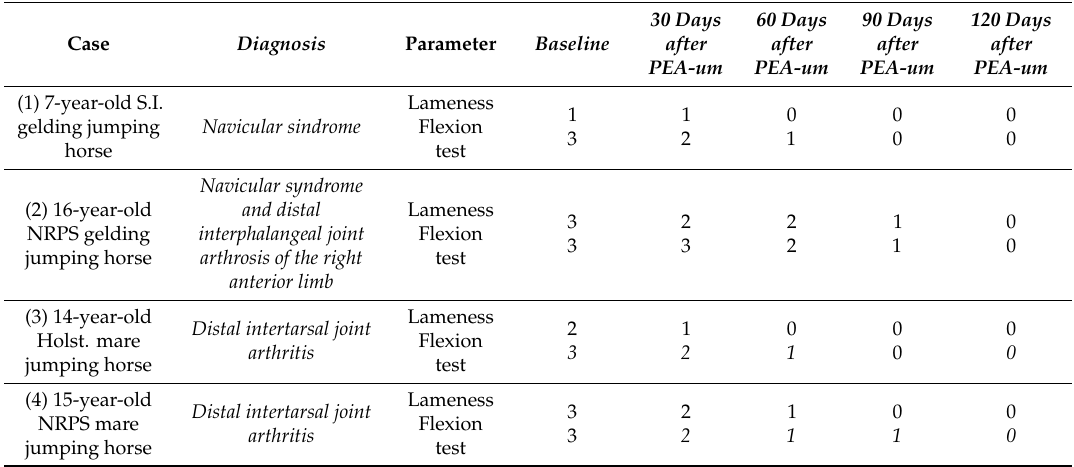
Table 1. Timeline of clinical outcome of horses treated with